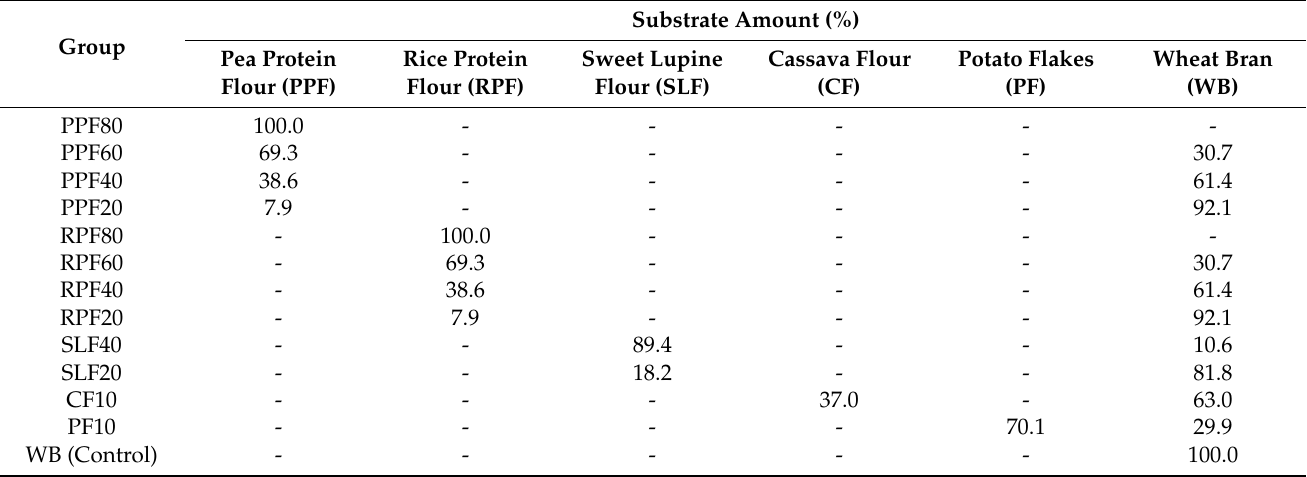
Table 1. Amount (%) of the individual substrates to create experimental diets for Tenebrio molitor larvae.